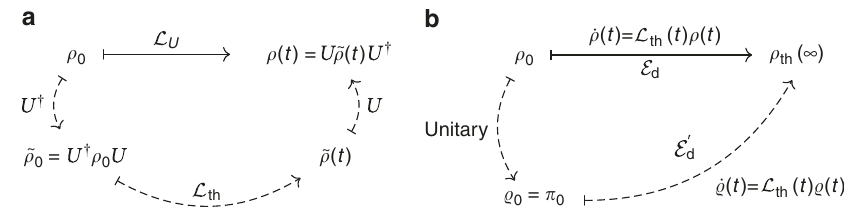
Fig. 9 Different evolution paths. a The evolution of an initial state ρ 0 in a non-thermal bath according to the Liouvillian L U (solid path) is unitarily equivalent to the evolution of a state ~ ρ 0 in a thermal bath according to the Liouvillian L th (dashed path). b The steady state reached by the relaxation of a non-passive state ρ 0 in a thermal bath (solid path) may also be reached by an alternative (dashed) path wherein the initial ergotropy is fi rst removed in a unitary a non-thermal bath towards ρ ss (solid arrow) may be replaced by a three-stage process (dashed arrows) wherein the system is in contact with a thermal bath only